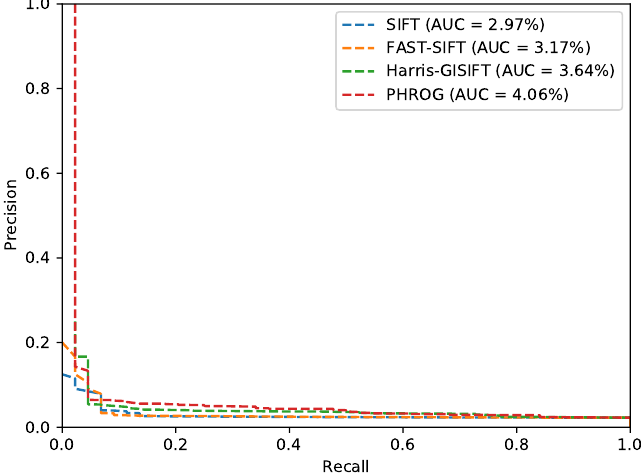
Figure 19. Precision-Recall curves from the “Barcelona” dataset and AUC ( Area Under the Curve ) for each